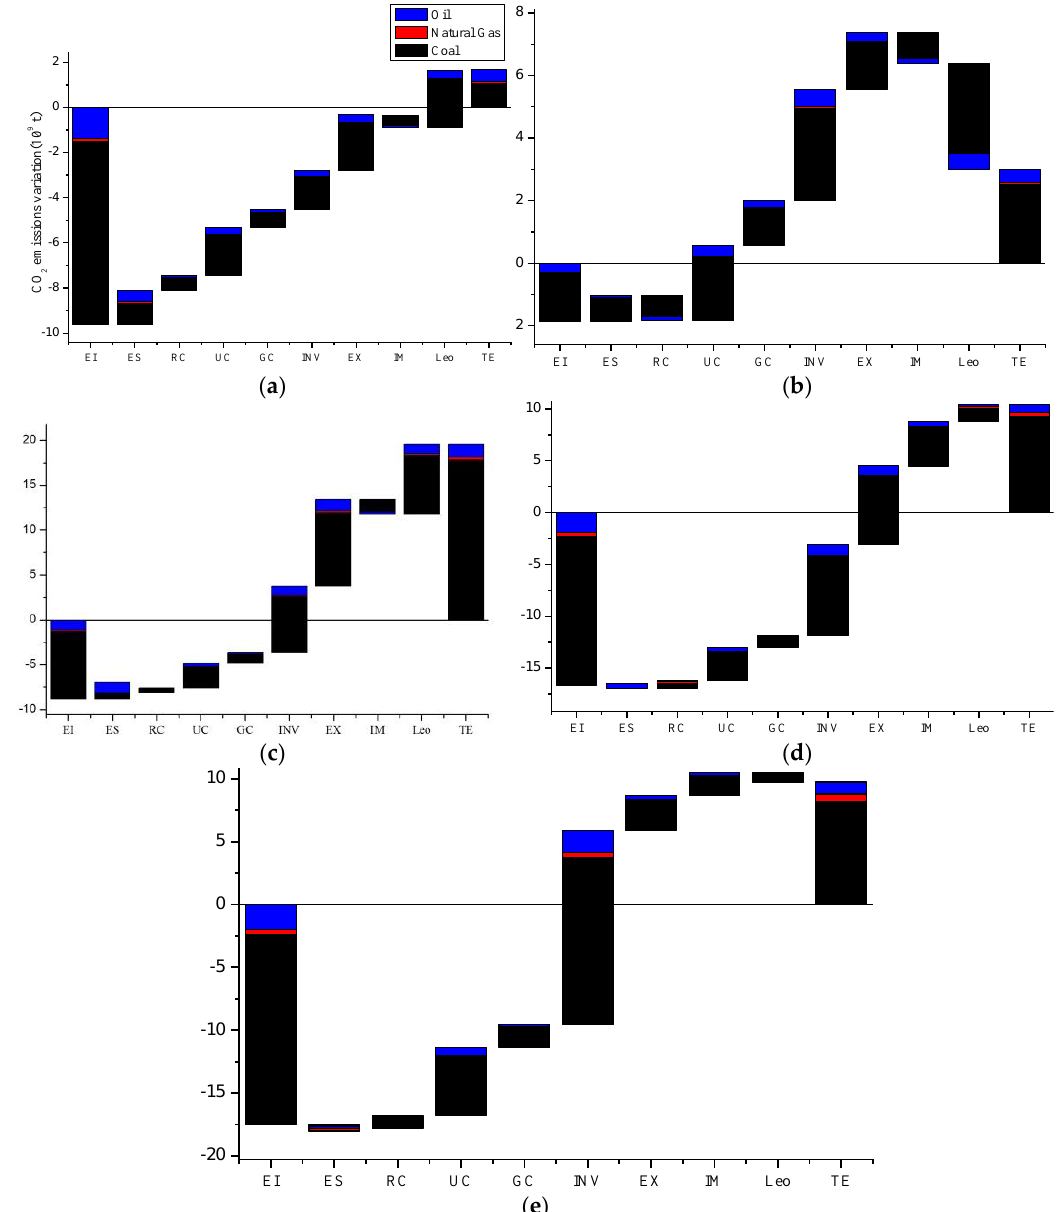
Figure 1. Contribution of different effects on CO 2 emissions changes in China. ( a ) changes in CO 2 emissions in 1997–2000; ( b ) changes in CO 2 emissions in 2000–2002; ( c ) changes in CO 2 emissions in 2002–2005; ( d ) changes in CO 2 emissions in 2005–2007; ( e ) changes in CO 2 emissions in 2007–2010.